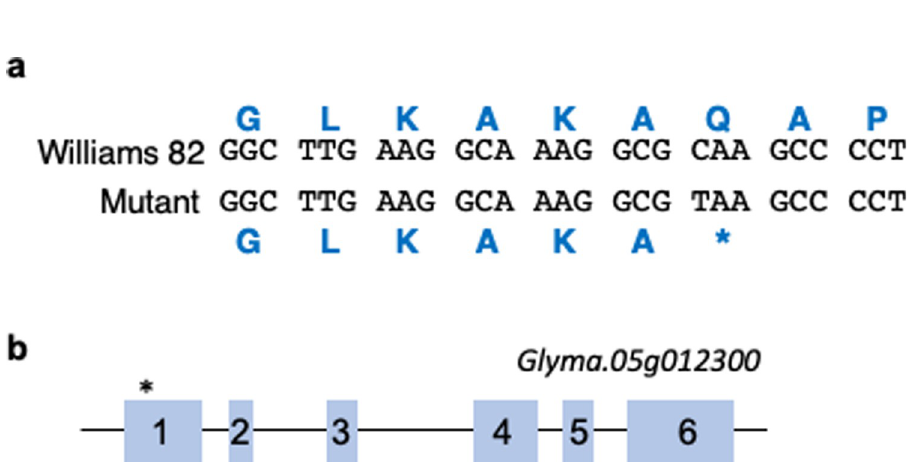
Fig 1. Palmitic acid content in F 2 seeds from complementation test cross to FATB1a measured in 49 F 2 individual seeds.